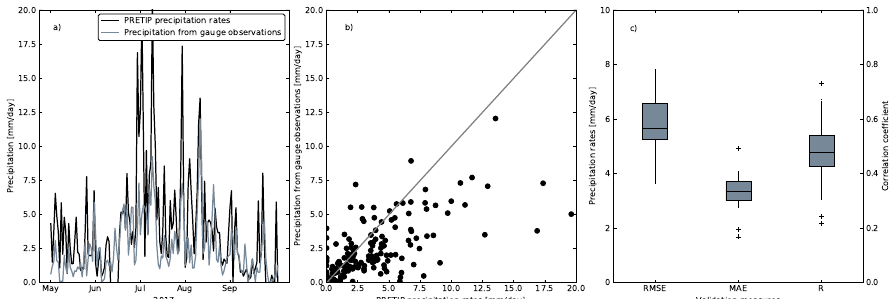
Figure 12. Temporal variation ( a ) and scatterplot ( b ) of daily precipitation from the Chinese rain gauge stations and the corresponding PRETIP precipitation pixels averaged for the complete study period. ( c ) shows the boxplots of the validation measures correlation coefficient R (right y -axis), MAE, and RMSE (both left y -axis) for the comparison of PRETIP in the 4 km resolution with the 28 Chinese rain gauge observations on the daily